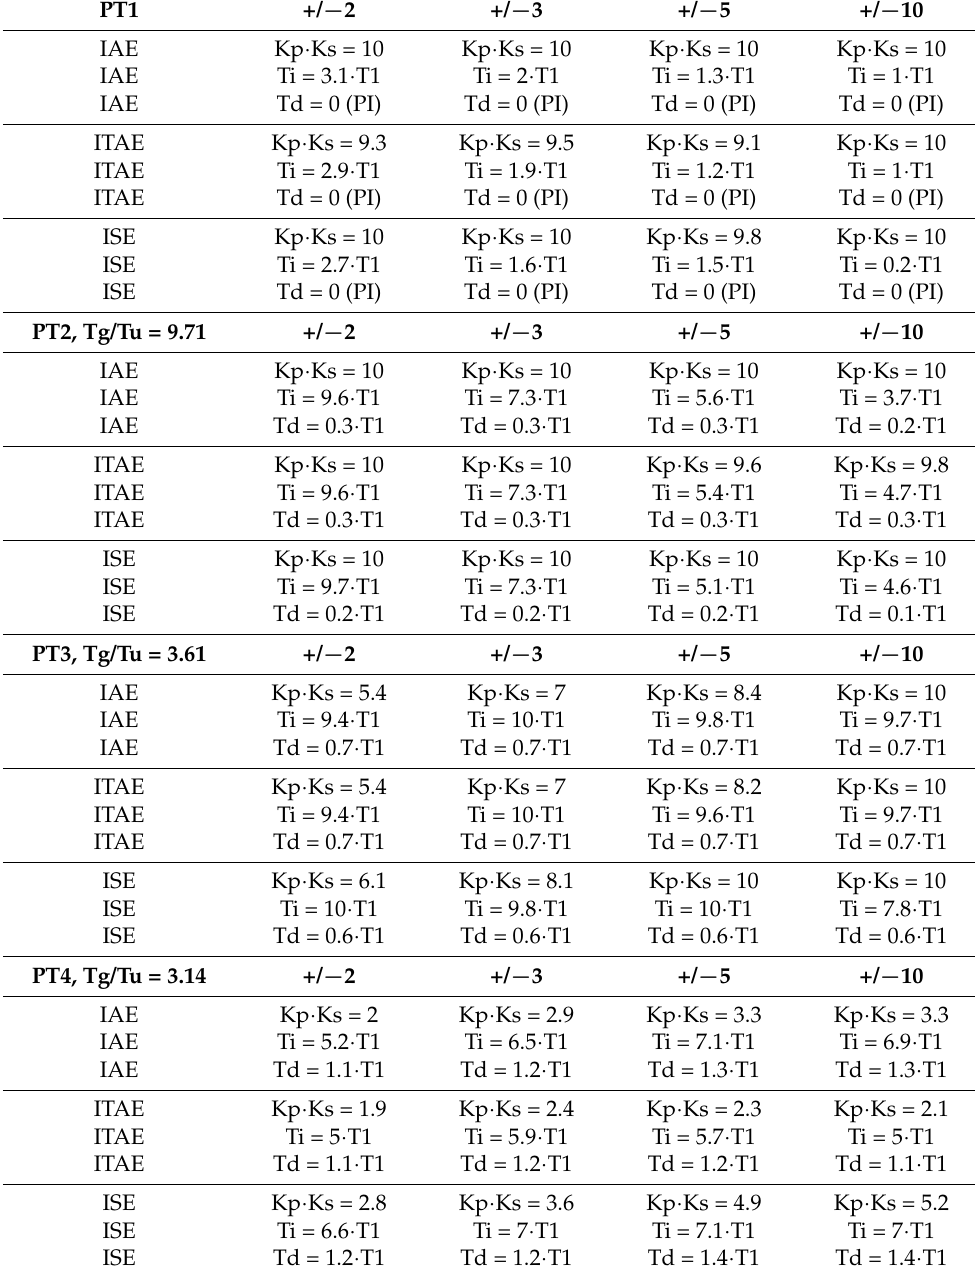
Table 2. PID parameters for minimized ITAE, IAE and ISE